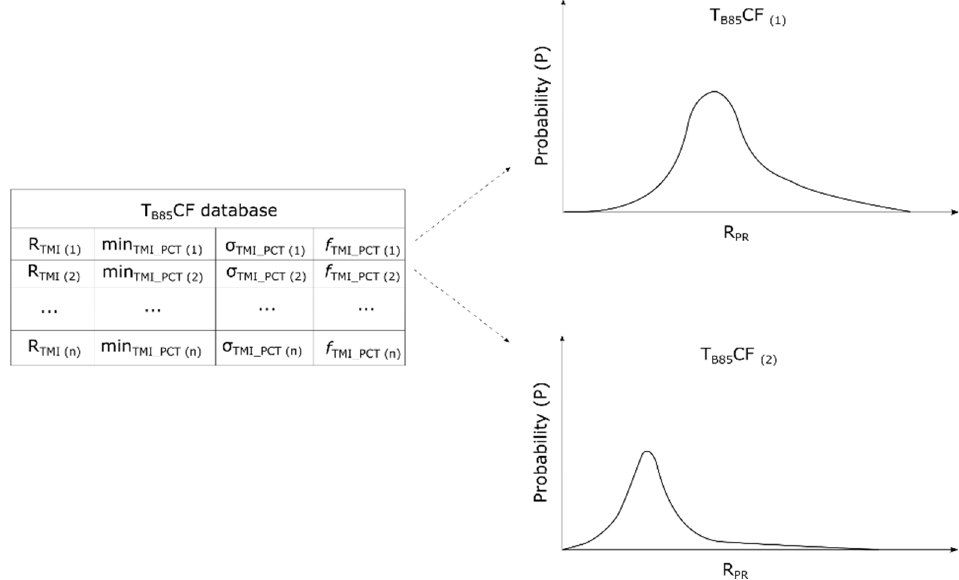
Figure 2. Illustration of the database that contain unique binned values of correction factor parameters (T B85 CF) and the corresponding probability of PR gridded rain-rate.